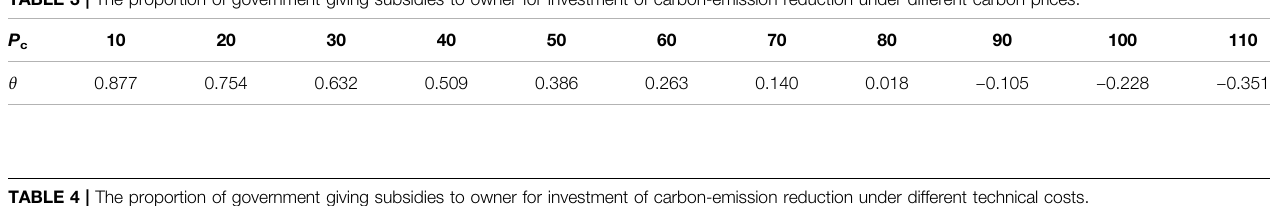
TABLE 4 | The proportion of government giving subsidies to owner for investment of carbon-emission reduction under different technical costs.